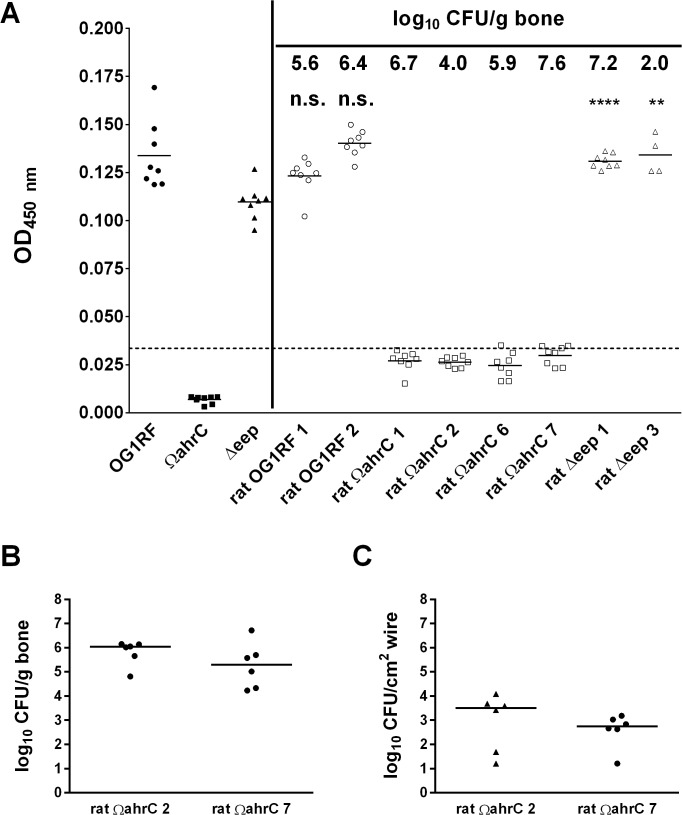
Passage through the rat foreign body osteomyelitis model does not affect in vitro biofilm formation (A) and degree of bone or wire colonization upon re-inoculation into the infection model (B).(A) Select E. faecalis isolates recovered from rat foreign body osteomyelitis experiments shown in Fig 1 were assayed for in vitro biofilm formation ability. The black symbols to the left of the vertical line show biofilm formation by independent cultures started with individual colonies of the parent OG1RF, ΩahrC, and Δeep isolates that had not been passaged through the rat foreign body osteomyelitis model. The open symbols to the right of the vertical line show biofilm formation by independent cultures inoculated from individual colonies of isolates of the three strains recovered from rat foreign osteomyelitis bone samples. The bacterial load of each bone sample (log10 CFU/g bone) from which the tested isolates were recovered is indicated at the top. Solid horizontal lines indicate means. The dashed horizontal line indicates 75% below the average biofilm biomass for the OG1RF parent strain. Isolates with means below the dashed line were deemed to be deficient in biofilm formation. Unpaired t-tests were used to compare biofilm formation by rat-passaged OG1RF or ∆eep isolates (right of vertical line) with the respective parent isolates (left of vertical line). n.s., not significant; ****, p-value < 0.0001; **, p-value < 0.01. (B) Quantitative bone culture results given as log10 CFU per gram of bone from rats infected with E. faecalis ΩahrC isolates recovered from rat infections shown in Fig 1. The isolate designated as rat ΩahrC 2 was recovered from an animal with a bone bacterial load of 4.0 log10 CFU/g bone. The isolate designated as rat ΩahrC 7 was recovered from an animal with a bone bacterial load of 7.6 log10 CFU/g bone. (C) Quantitative wire culture results given as log10 CFU per cm2 of wire surface from rats infected with E. faecalis isolates rat ΩahrC 2 and rat ΩahrC 7, which were recovered from the animal infections shown in Fig 1. In (B) and (C), horizontal lines represent the medians.